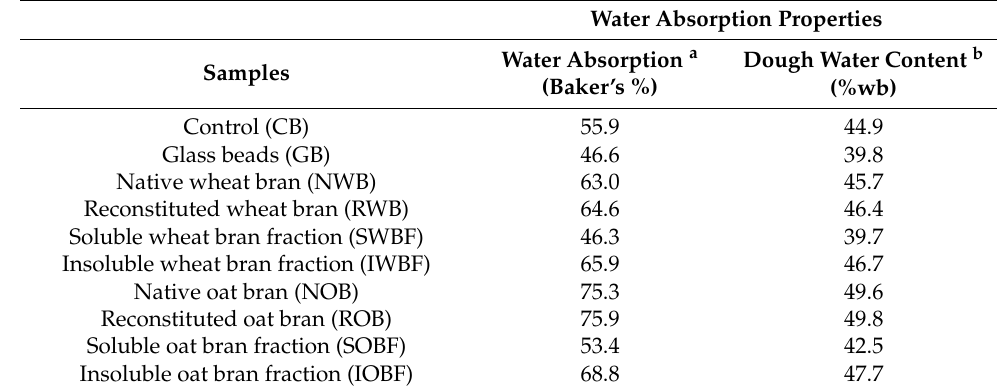
Table 1. Water absorption from farinograph tests with corresponding dough water content for the different doughs in the